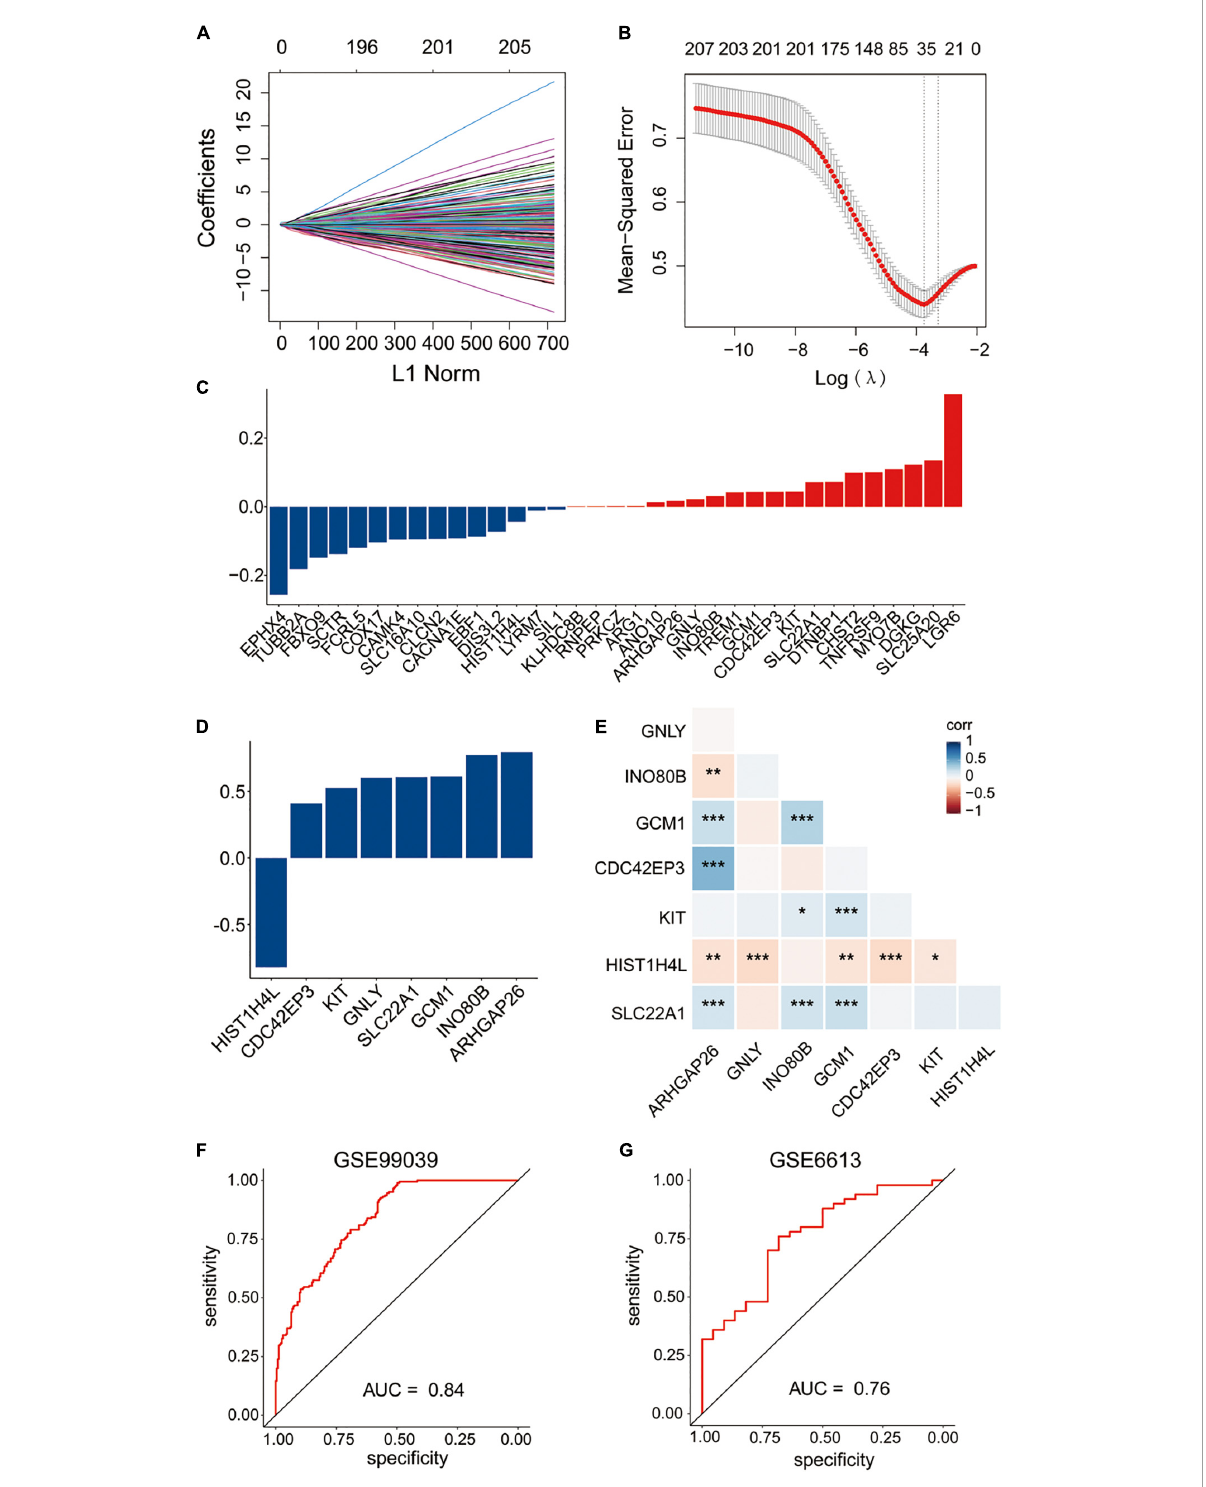
FIGURE4 Construction of the diagnostic signature based on methylation-driven genes. (A,B) LASSO regression was performed to calculate the coefficients (A) and minimum criteria (B) . (C) Coefficients of 35 methylation-driven genes selected by LASSO regression. (D) Coefficients of eight methylation-driven genes in the signature selected by the stepwise logistic regression analysis. (E) Spearman correlation analysis of the eight genes. (F) ROC curve of the signature in the training set GSE99039. (G) ROC curve of the signature in the testing set